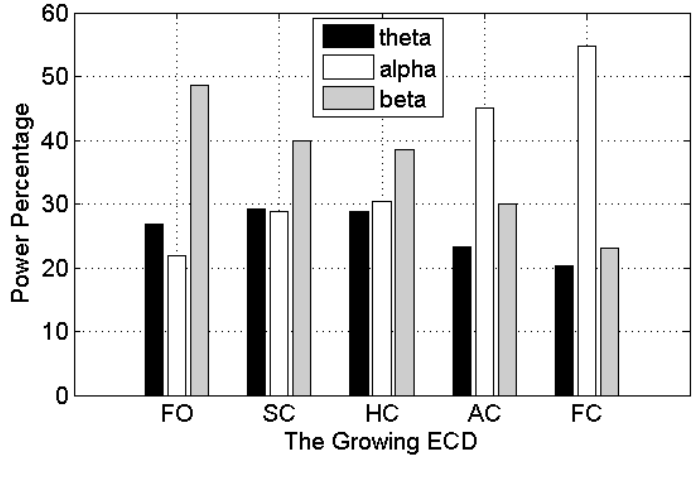
Figure 7. The EEG power spectrum features with the growth of